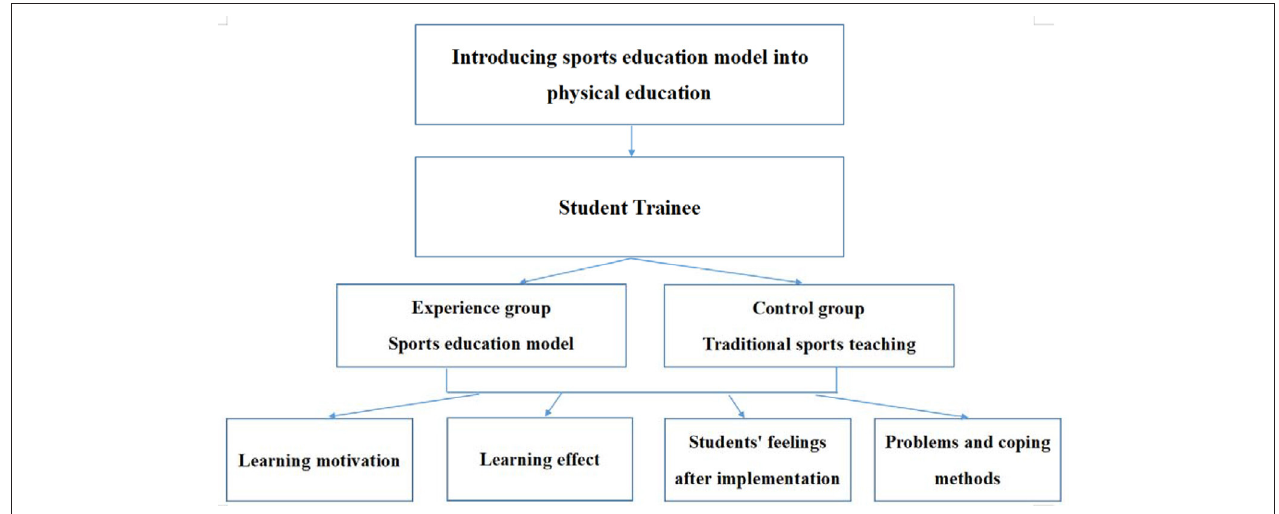
FIGURE 1 | Research